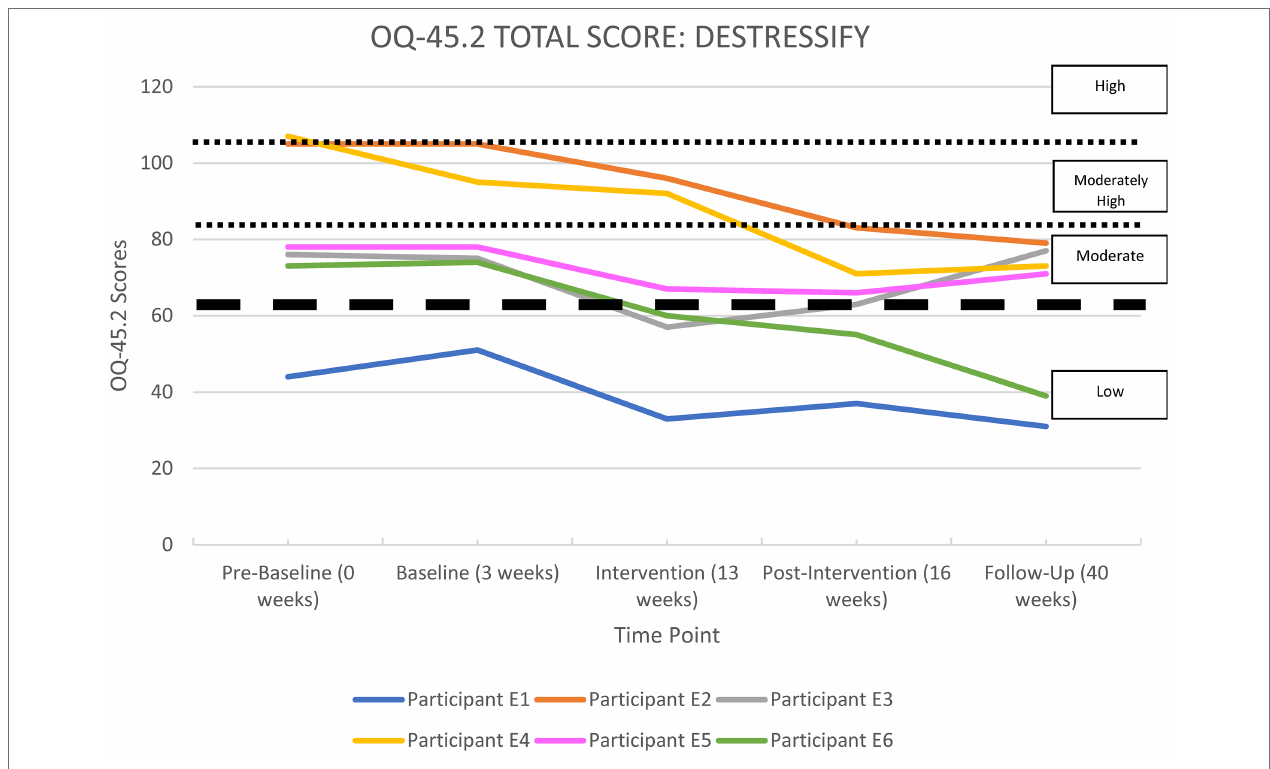
FIGURE 6 | OQ-45.2 total scores for Destressify .